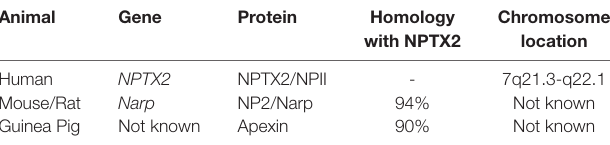
TABLE 2 | Relative amino acid homologies of NPTX2 variants with the human protein form. Animal Gene Protein Homology Chromosome with NPTX2 location Human NPTX2 NPTX2/NPII - 7q21.3-q22.1 Mouse/Rat Narp NP2/Narp 94% Not known Guinea Pig Not known Apexin 90% Not